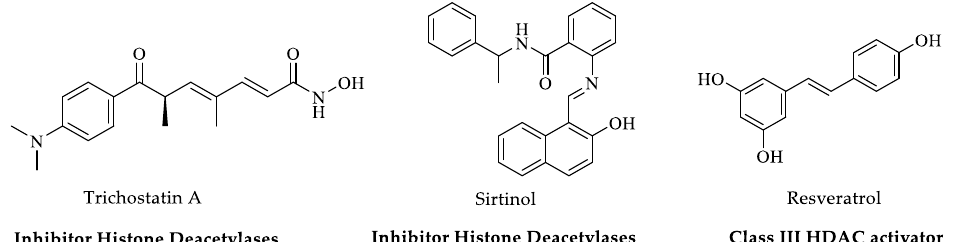
Figure 2. Structure of compounds with epigenetic effects against T. cruzi .